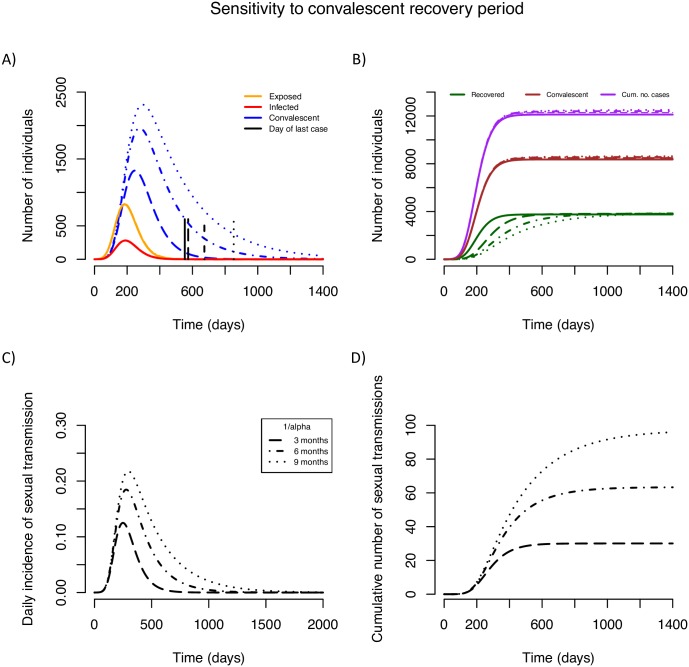
Effect of per sex act transmission probability on EVD epidemics.The per sex act transmission probability (η) is varied between 0.05% and 0.2%. (A, B): Epidemic trajectories in presence (broken lines) and absence of sexual transmission (solid lines). Vertical lines mark the day of last symptomatic case. (C) Daily incidence of sexual transmission. (D) Cumulative number of sexual transmission events. Note that the vertical axes vary across panels.